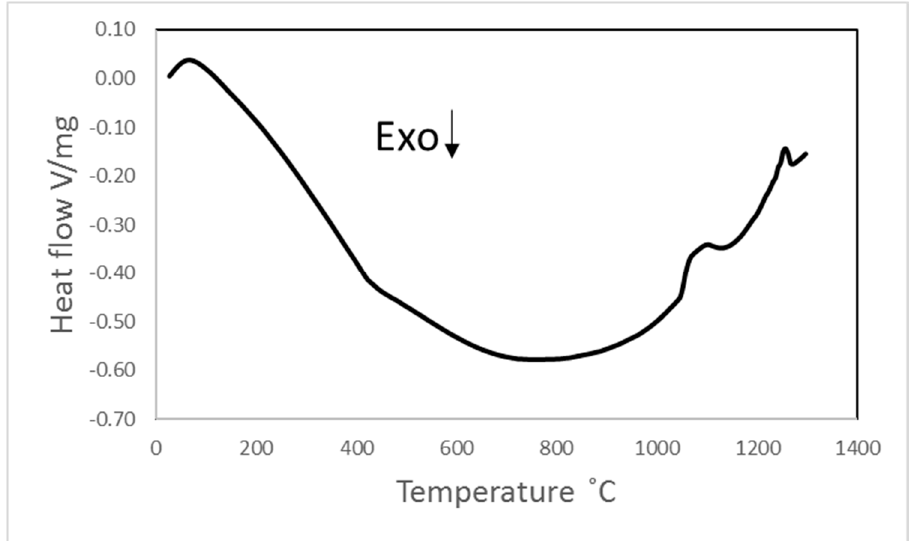
Figure 4. DSC curve of the as-milled NiMnFeCu HEA after 20 h of milling.